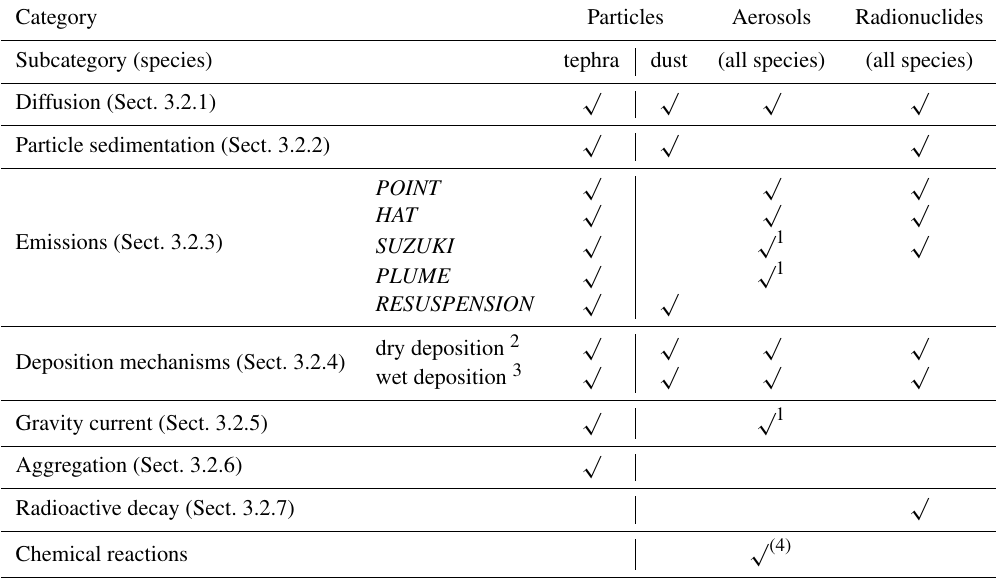
Table 4. Parameterisations available in FALL3D-8.0 depending on each category and related subcategory (species). Note that, except for radioactive decay, all physical phenomena were already included in v7.x. However, several parameterisations have been updated to account for more recent